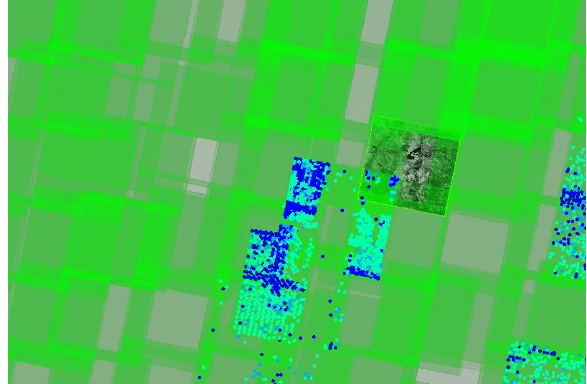
Figure 13. Unreasonable distribution of connection points (1)